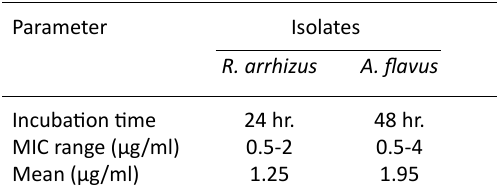
Journal of Pure and Applied Microbiology